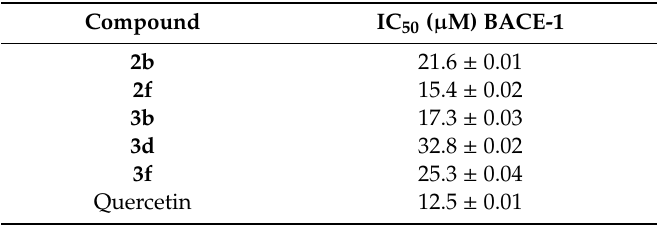
Table 4. β -Secretase inhibitory activity of compounds 2b , 2f , 3b , 3d and 3f